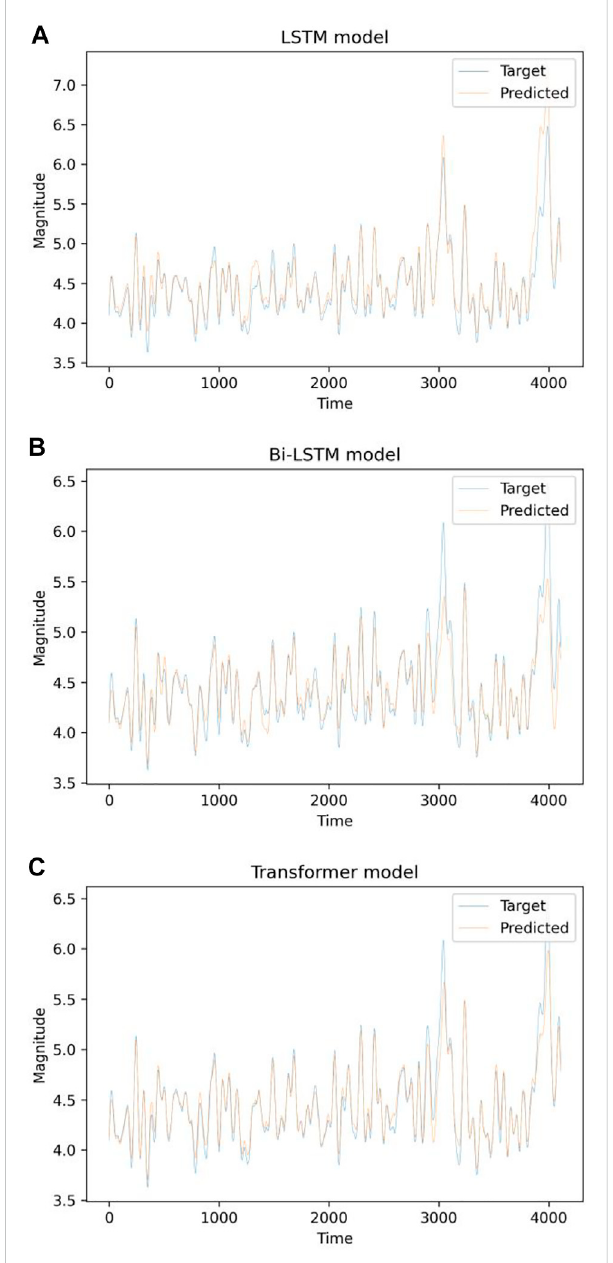
FIGURE 15 Plot of observed magnitude against anticipated